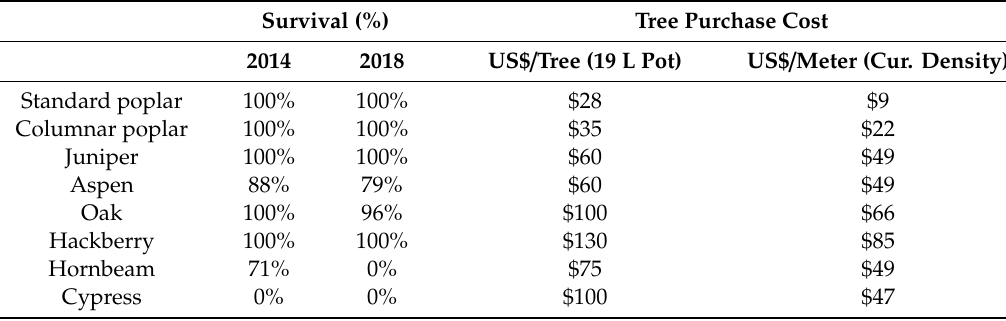
Table 2. Survival and cost of trees. Survival of windbreak trees is shown for one (2014) and five (2018) years after planting. Cost (USD) of a single tree grown in a standard 18.9 L (#5) container, shown per tree and per linear foot. Pricing obtained from local and internet nurseries. Trees such as Standard poplar and Columnar poplar have high survival rates and are relatively inexpensive. Survival